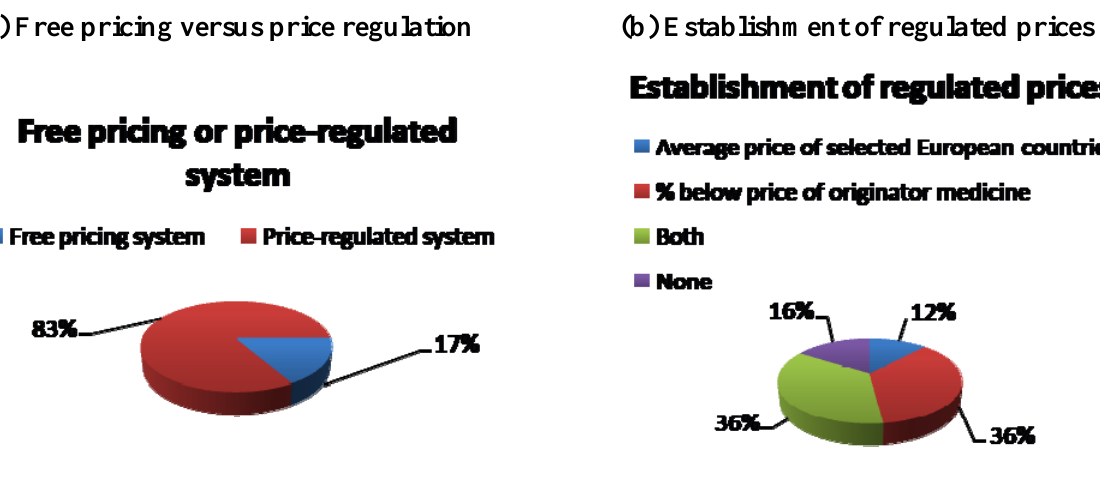
Figure 3. Generic medicine pricing systems in Europe,